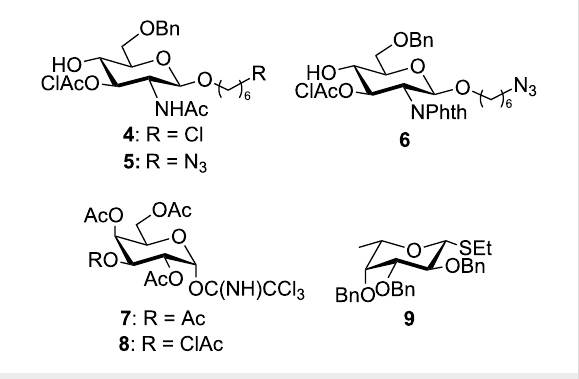
Figure 2: Monosaccharide glycosyl acceptors ( 4 – 6 ) and donors ( 7 – 9 ) used in this